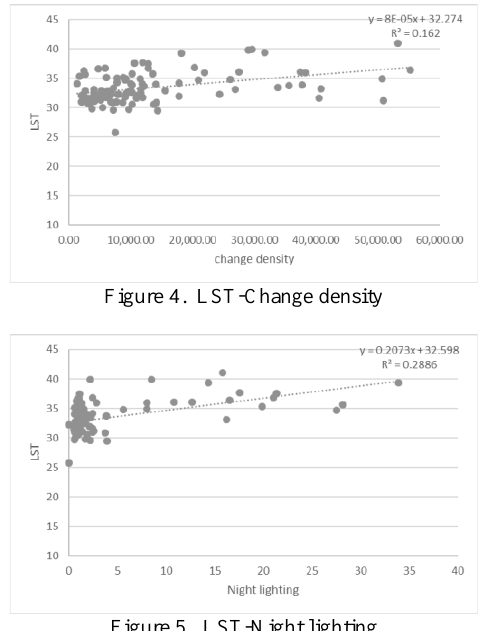
Figure 5. LST-Night lighting People's migration and aggregation are mostly related to traffic factors. Roads connect different towns and regions, which to a certain extent accelerates the formation of heat island. The distribution of heat island in Qingdao coincides with that in places with high density of road network, which indicates that the relationship between heat island and road is positive. The same conclusion can be drawn from the results of regression analysis in Figure 6. Through overlay analysis between rules between different inversion results found that the population aggregation, change pattern and heat island effect in Jiaozhou are more intensive, but the corresponding road density is not high. It is suggested that the later planning should focus on road